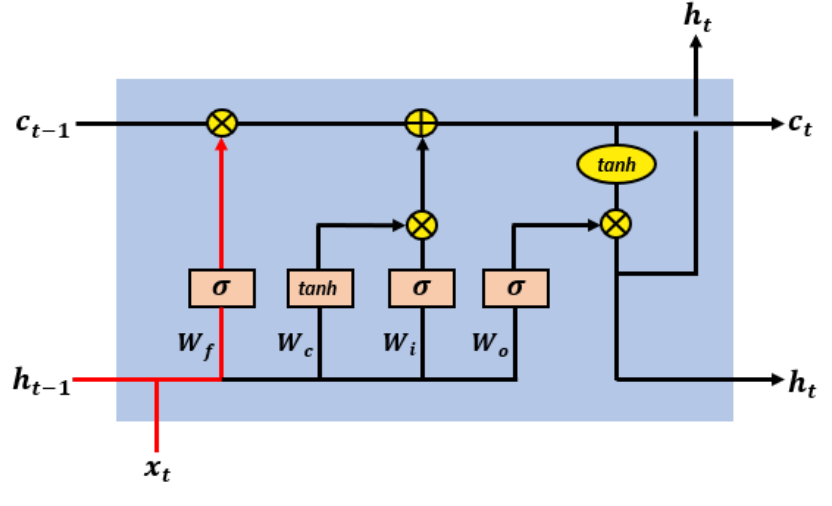
Figure 3. LSTM Architecture